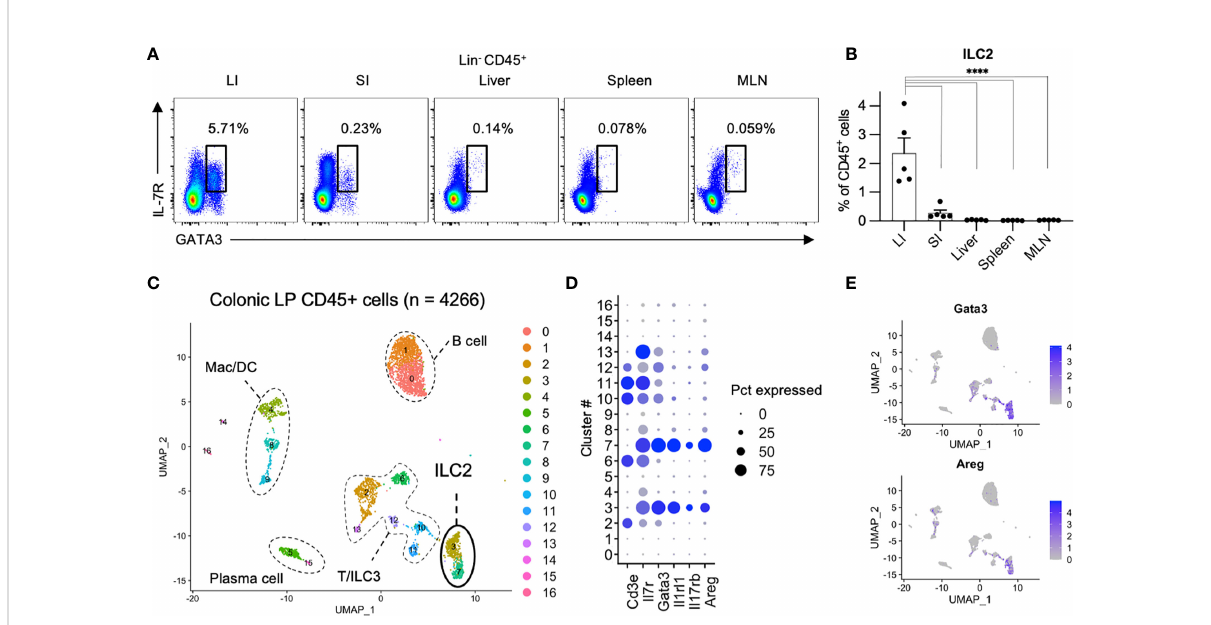
FIGURE 1 Comparison of ILC2s across digestive organs (A, B) Representative fl ow cytometry plots (A) and frequencies among CD45 + lymphocytes (B) of Lin − CD127 + GATA3 + ILC2s in the colon (LI), small intestine (SI), liver, spleen, and mesenteric lymph nodes (MLN) of SPF (speci fi c pathogen free) mice. n=5 for each tissue. Data are representative of two independent experiments (mean and SEM in B). (C – E) ScRNA-seq analysis of colonic CD45 + cells. (C) Uniform manifold approximation and projection (UMAP) of CD45 + cells (n=4266) derived from pooled 5 SPF mice, showing the formation of 16 main clusters represented by different colors. The functional description of each cluster is determined by the gene expression characteristics of each. (D) Dot plot visualizing the expression of representative genes of ILC2s. The color represents the average expression level, and the circle size represents the proportion of cells expressing each gene. (E) Expression levels of the speci fi ed marker genes on the UMAP plots. **** P <